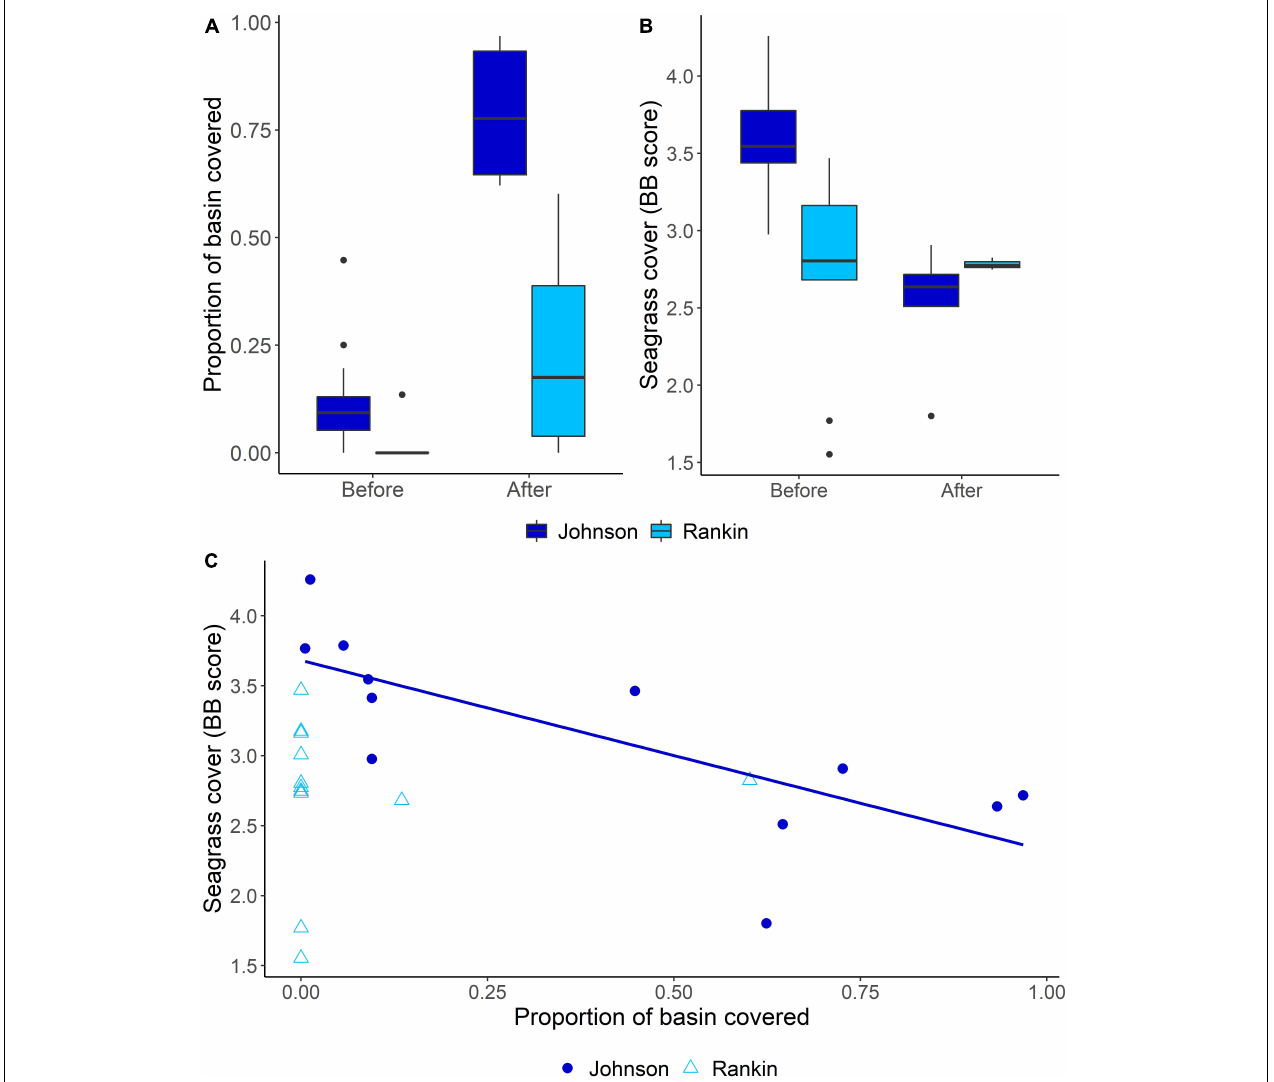
FIGURE 6 | Summary of ANOVA and correlation analyses. (A) Mean proportions (and 95% confidence intervals) of Johnson and Rankin Basins covered by the sediment plume before and after the breakpoints. (B) Mean (and 95% confidence interval) Braun-Blanquet seagrass cover in Johnson and Rankin before and after the breakpoints. (C) Relationship between the proportion of each basin covered by the sediment plume and the mean seagrass cover of each basin shown separately by basin, showing the significant regression line for Johnson Basin. Linear regression model shown for Johnson Basin has an R 2 value of 0.55 following the following equation: y = –1.4x +